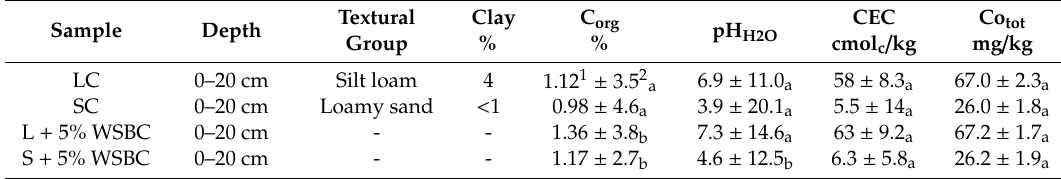
Table 1. Selected properties of soils from the incubation